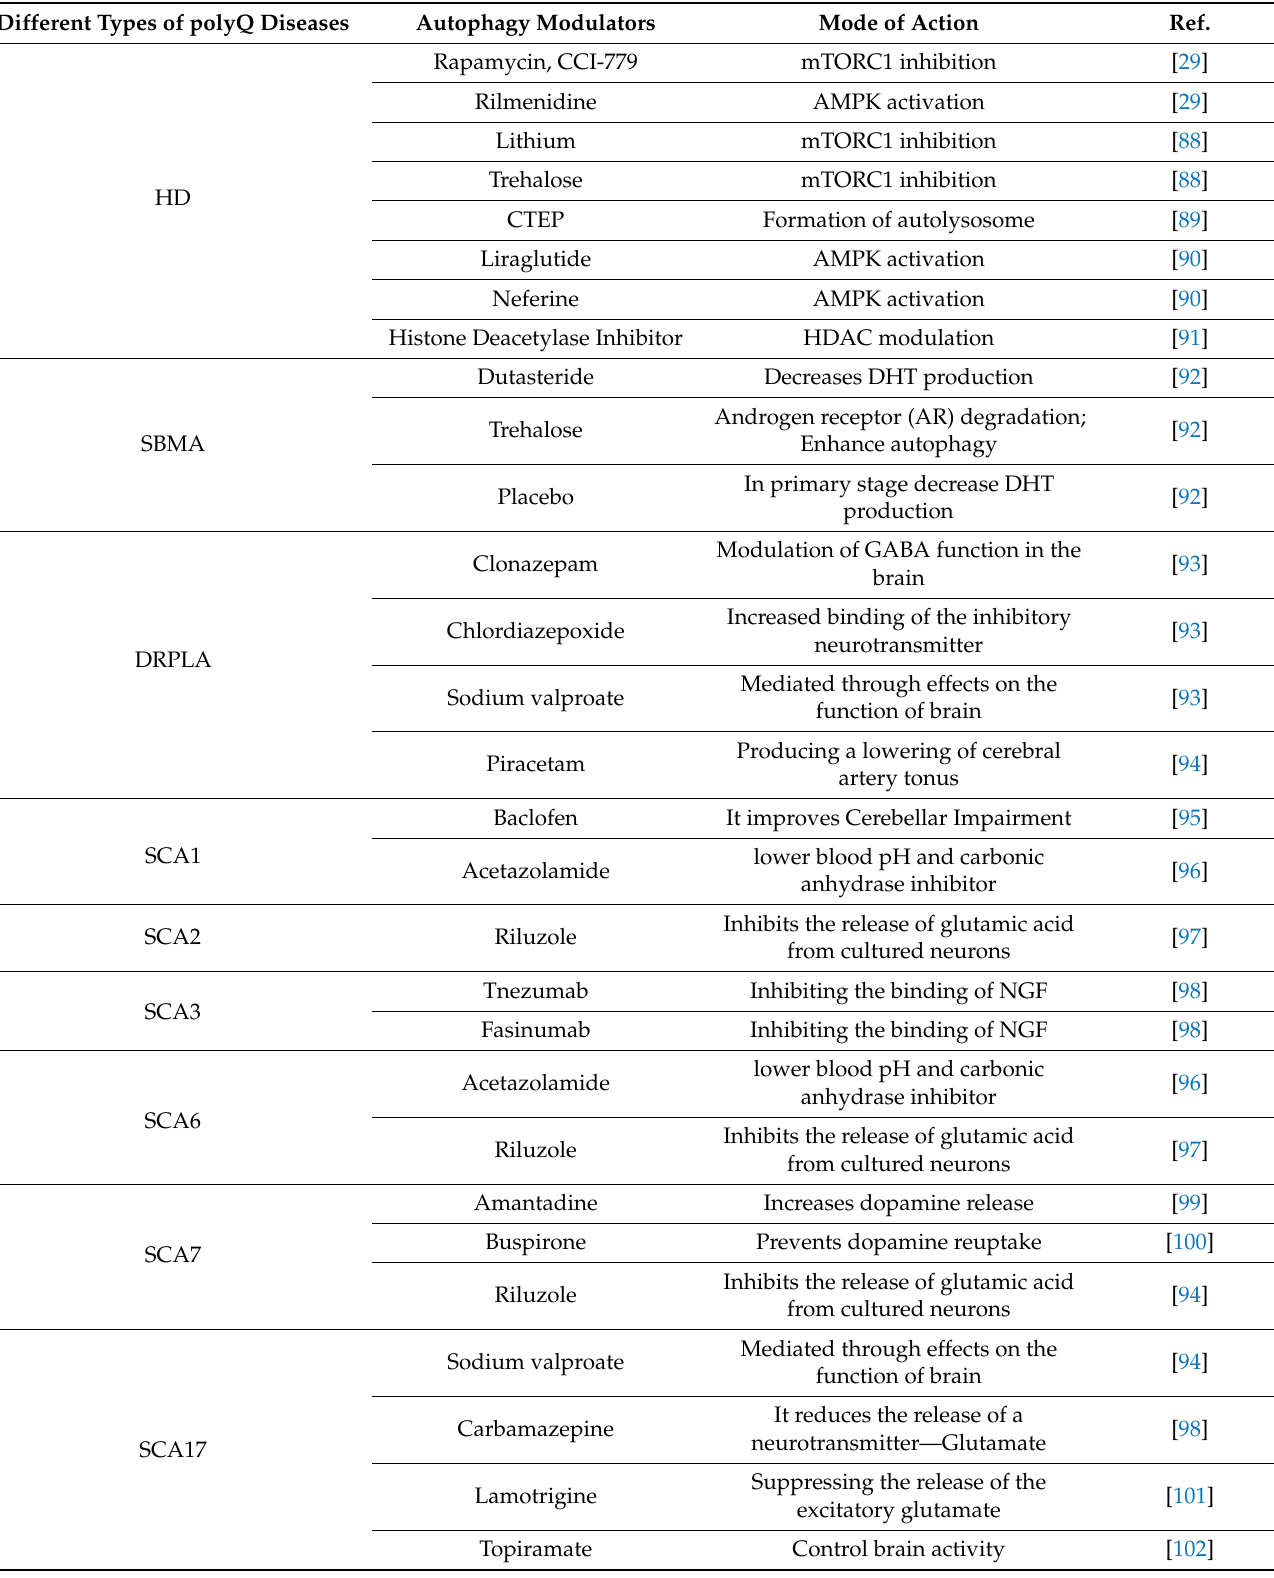
Table 1. Therapeutic effects and modes of action of autophagy modulators in relation to polyQ